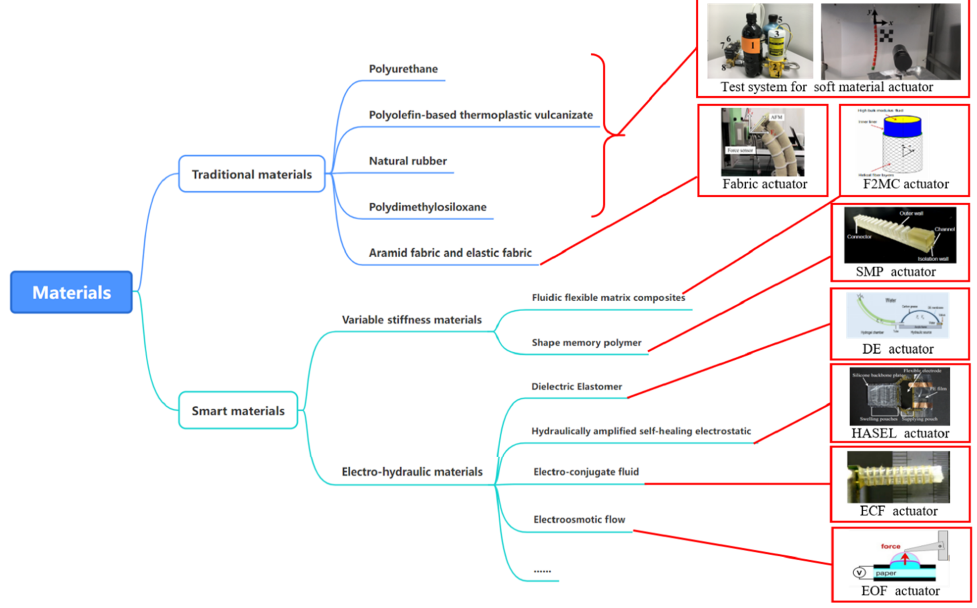
Figure 2. Fabrication materials of hydraulic powered soft actuators